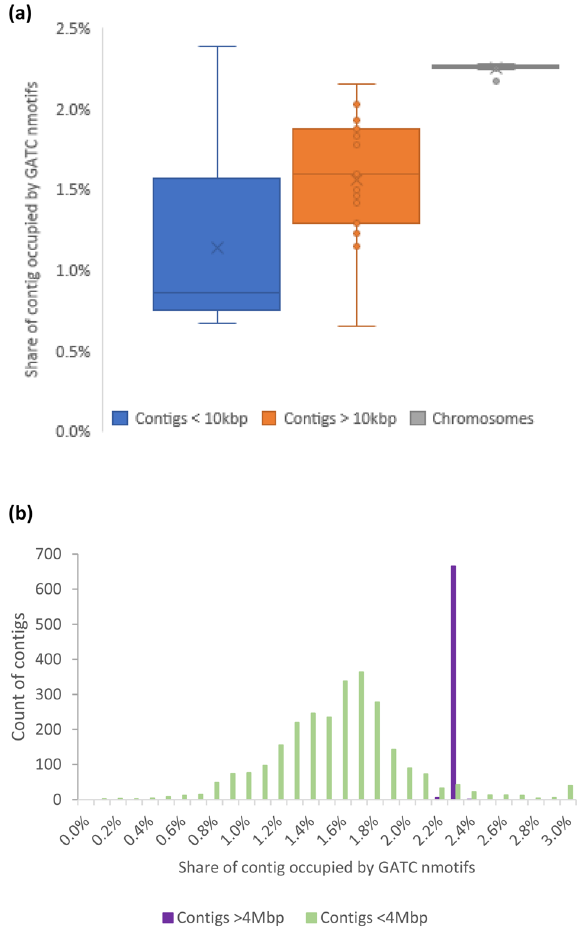
Figure 2. ( a ) The share of genomic elements occupied by a GATC motif in the assemblies in Table 1. The largest non-chromosome contig, 284kbp, has abundance ratio of 1.8%. ( b ) GATC abundance in 673 high quality assemblies of Kp taken from NCBI database limiting sequences to those that have N50 in excess of 5Mbp. The mean chromosomal GATC abundance in ( a ) and ( b ) is the same.